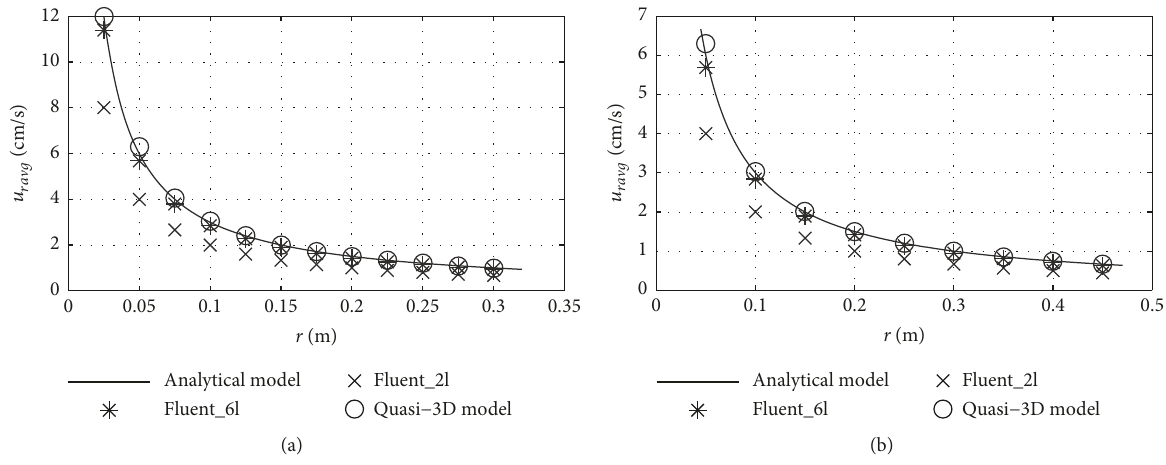
Figure 10: Distribution of average flow velocity over the radius at different times in Case 1 (a) t = 20 s; (b) t = 40 s. Table 6: Description of three models and average relative errors of the solution.